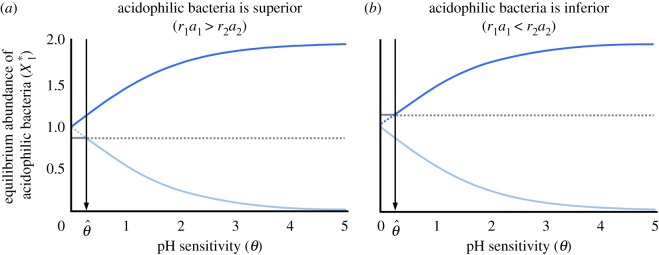
Equilibrium abundance of acidophilic bacteria varies with sensitivity to pH. (a) r1a1 > r2a2. (b) r1a1 < r2a2. The different colours indicate three equilibria. Dotted and solid lines indicate locally unstable and stable equilibria, respectively. The arrows indicate the threshold value of θ at which the stability shifts (θ^). In (a), r1 = 2, a1 = 1.3, r2 = 2 and a2 = 1. In (b), r1 = 2, a1 = 1, r2 = 2 and a2 = 1.3.